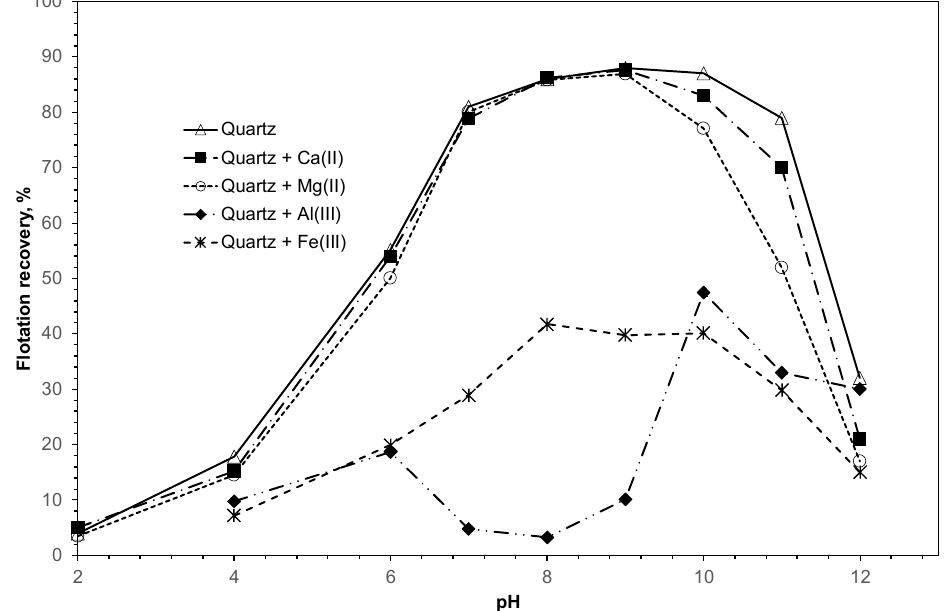
Figure 4. Flotation recovery of quartz in the absence/presence of Ca 2+ , Mg 2+ , Al 3+ or Fe 3+ ions at a concentration of 1 mmol/L as a function of pH.